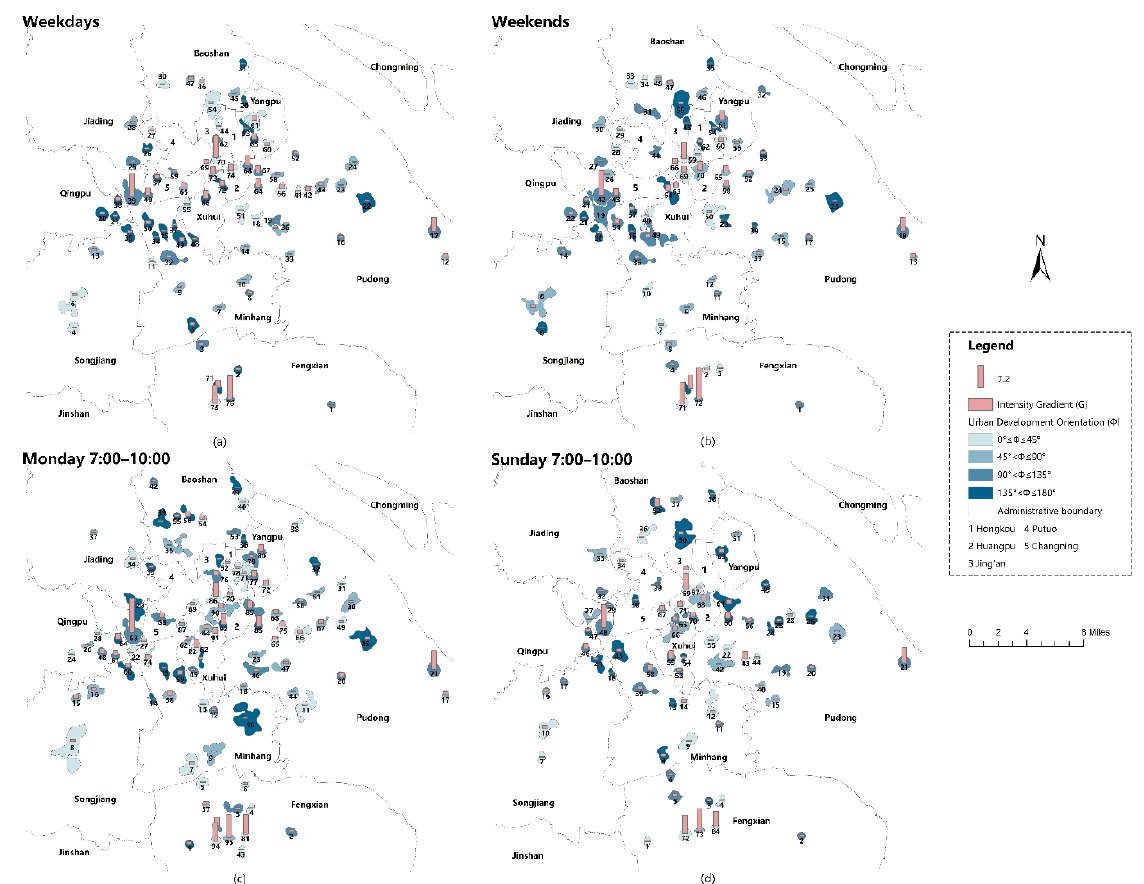
Figure 10. The compactness of MUCs. ( a ) A comparison between weekdays and weekends; ( b ) a comparison between Monday and Sunday.